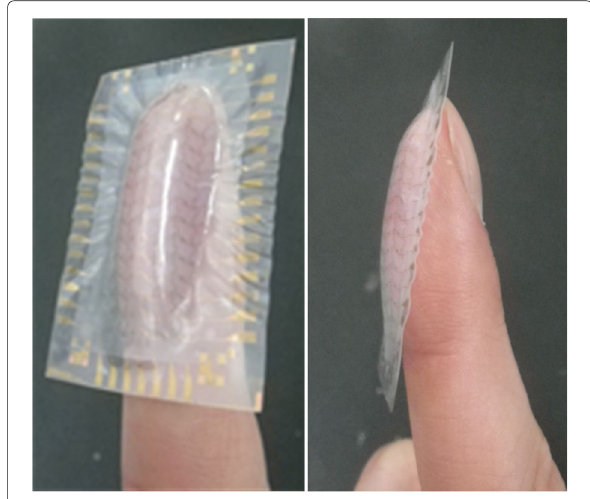
Fig. 3 Photograph of fingertip-shaped OTFT array on the human finger